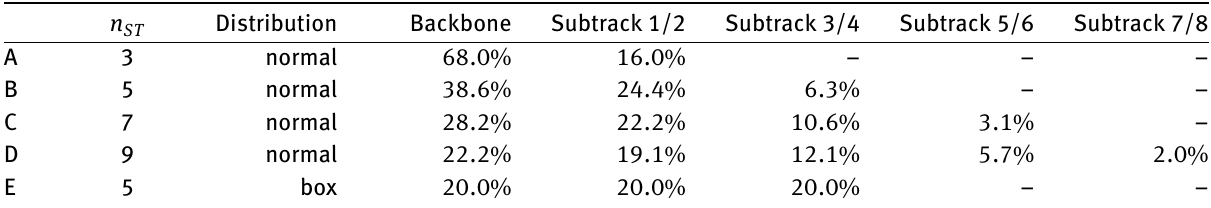
Table 1: Movement percentages for the examples, denoted as cases A – E, each case representing a combination of number of subtracks n ST and lateral distribution shape.